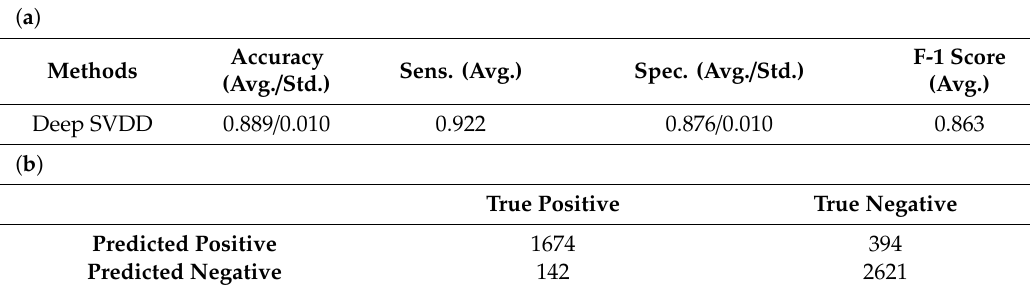
Table 4. Performance measurement ( a ) and the confusion matrix of one test fold ( b ) for Deep SVDD approach on test images. Positive: non-cervix image. (Sens. = Sensitivity, Spec. = Specificity, Std. = Standard deviation, Avg. = Average).